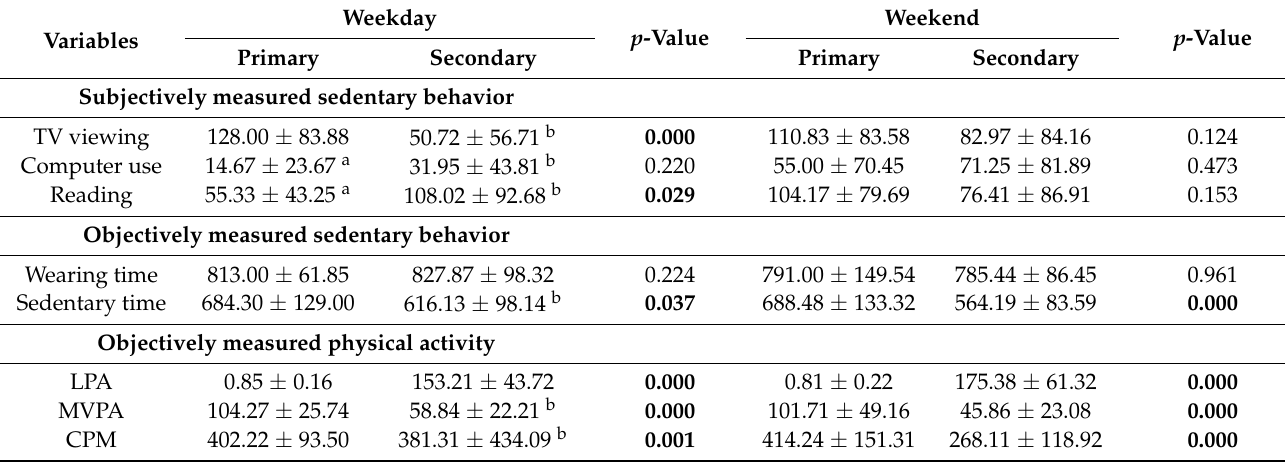
Table 3. Patterns of sedentary behavior and physical activity (minutes/day) between primary and secondary school youths with autistic spectrum disorder (ASD) on weekdays and